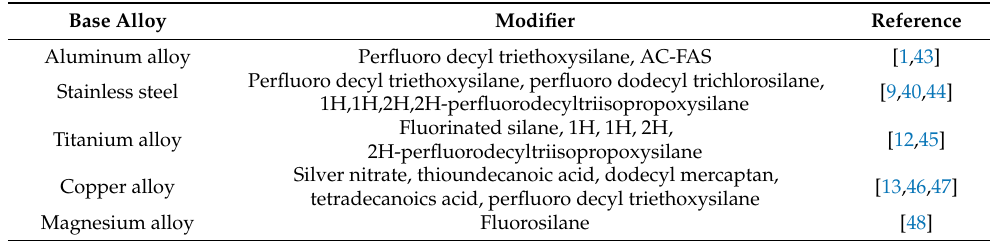
Table 3. Common surface